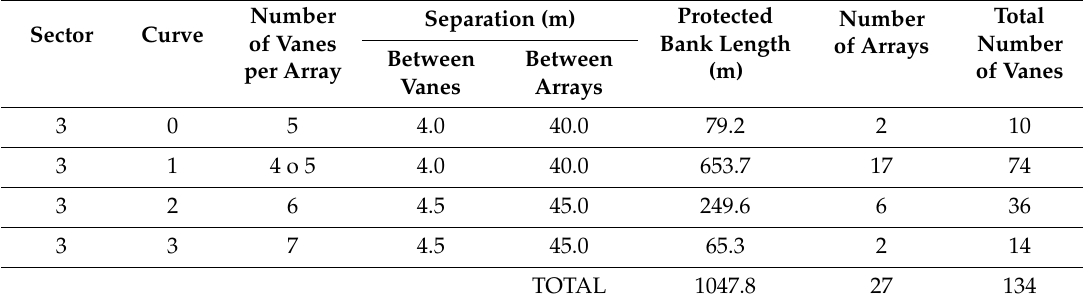
Table 2. Redesign of the submerged vane system for the Metica River in Puerto L ó pez, Department of Meta (Hidroconsulta [12]).